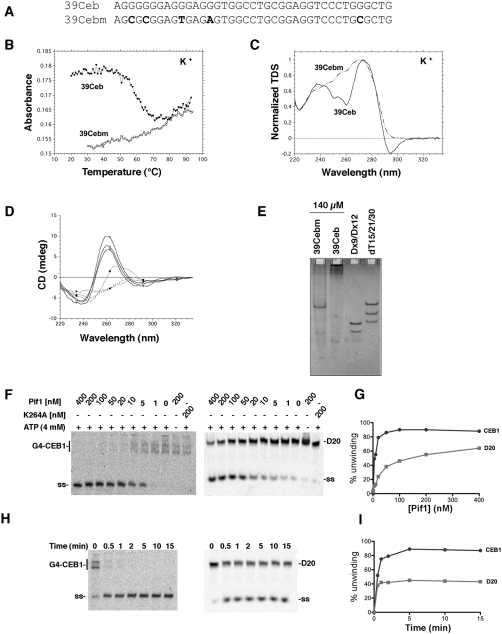
Evidence for G4 structures formation by CEB1 minisatellite sequences.(A) Oligonucleotide sequences. The 39Ceb oligonucleotide mimicks one full CEB1 repeat. 39Cebm is a control sequence with five base substitutions (shown in bold) (B) Melting profiles. Absorbance at 295 nm vs temperature plots for 39Ceb (triangles) and 39Cebm (circles) each at 3 µM strand concentration. Melting experiments are performed in 10 mM lithium pH 7.2 cacodylate buffer supplemented with 0.1 M KCl. (C) Thermal difference spectra. Thermal difference spectra result from the difference between the absorbance recorded at 79±2°C and at 40±2°C in a 10 mM lithium pH 7.2 cacodylate buffer supplemented with 0.1 M KCl. Thermal difference spectra are normalized (TDSnorm = TDS/max(TDS)) over the 220–335 nm wavelength range. Full line: 39Ceb; dotted line: 39Cebm. (D) Circular dichroism spectra. Oligonucleotides were prepared at 140 µM strand concentration and annealed in 1 M NaCl as in helicase experiments, then immediately diluted to 3 µM in a 10 mM lithium cacodylate 1 M NaCl, pH 7.2 buffer. Full line: 39Ceb; dotted line: 39Cebm. Spectra were recorded at three different temperatures: 25°C (squares), 65°C (circles) and 90°C (triangles). (E) Behavior of the 39Ceb and 39Cebm sequences on a non-denaturing gel. Oligonucleotides were prepared at 140 µM strand concentration, annealed in 1 M NaCl as in helicase experiments and loaded on a non-denaturing 15% acrylamide gel supplemented with 20 mM NaCl and run at 21°C. Migration markers are 1: double-stranded DNA (9 and 12 bp) and 2: (dT)15, (dT)21 and (dT)30 oligomers. (F) In vitro unwinding of 2 nM G-quadruplex DNA (G4-CEB1, left) versus 2 nM double stranded DNA oligonucleotide substrate (D20, right) in presence of decreasing amount of Pif1 (WT or helicase-dead pif1-K264A) for 15 minutes at 35°C in presence or absence of ATP. (G) Quantifications of the gels shown in F. (H) Kinetics of unwinding of G-quadruplex DNA (left) versus double stranded DNA oligonucleotide D20 (right) in presence of 100 nM Pif1. (I) Quantifications of the gels shown in H.